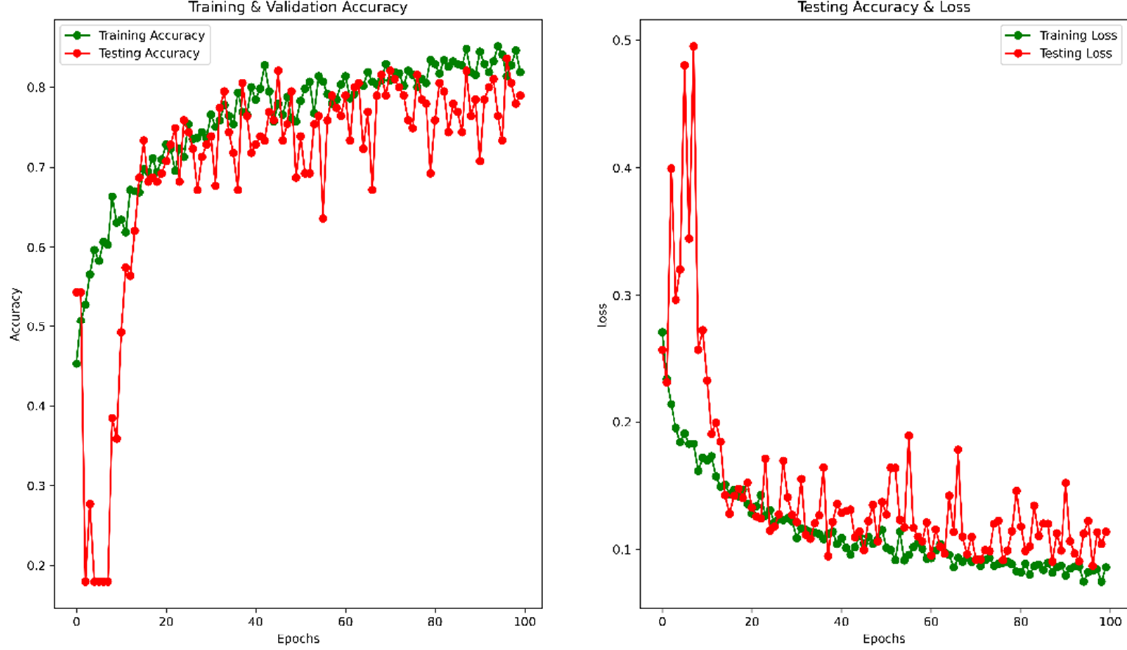
Figure 9. Accuracy and Loss vs Epoch for original image in classification.